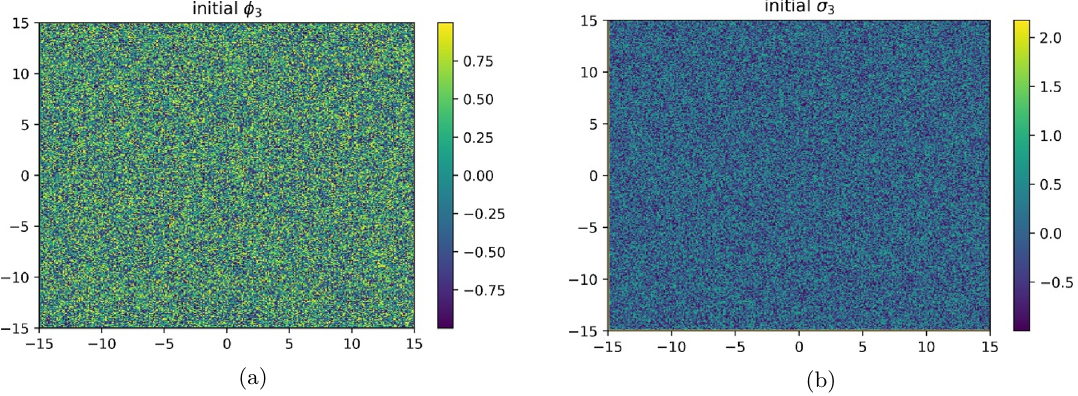
Figure 4. A random initial configuration. Every component at every point is a random number from -1 to 1. This relaxes to figure 5. The parameters of the problem are the same as those given in the caption of figure 3. Just like there, we are only displaying the (a) real and (b) imaginary parts of the third vector component, when there are really 5 − 1 = 4 components. Note that the maximum values (and hence colors) are different between the two pictures because they both need to satisfy the boundary condition of their respective